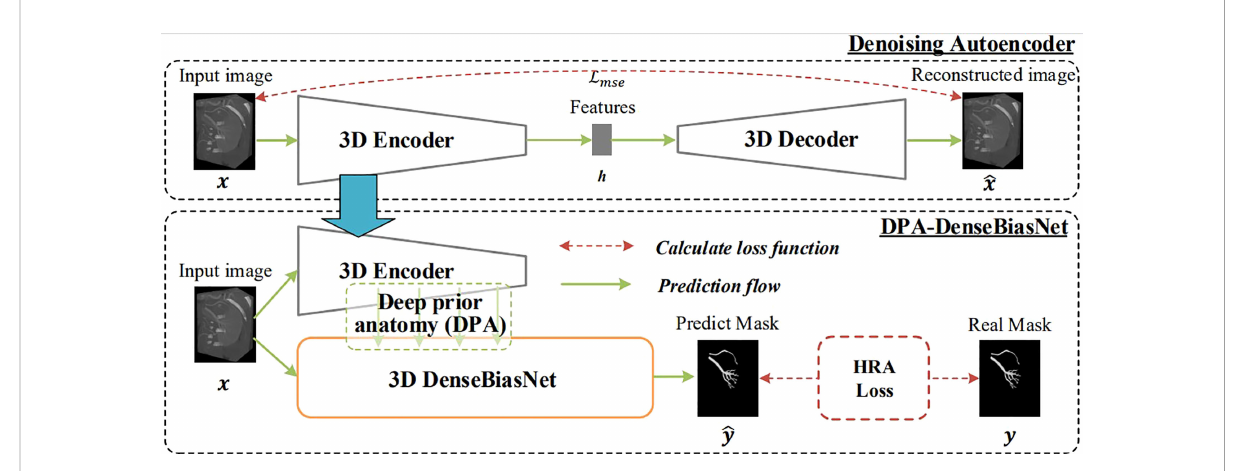
FIGURE 2 The 3D DPA-DensebiasNet framework is applied in the automatic segmentation of renal artery trees. The procedure includes two stages. Stage 1(the upper dotted box): is AE pre-training. The AE is trained by a lot of unlabeled images and DPA features are extracted. Stage 2 (the lower dotted box): extracted DPA features from AE are embedded in the DenseBiasNet system, forming the priori anatomy information, which can adapt anatomical variations. And fi nally, modi fi ed by HRA loss function, a precise tridimensional renal artery segmentation is achieved.